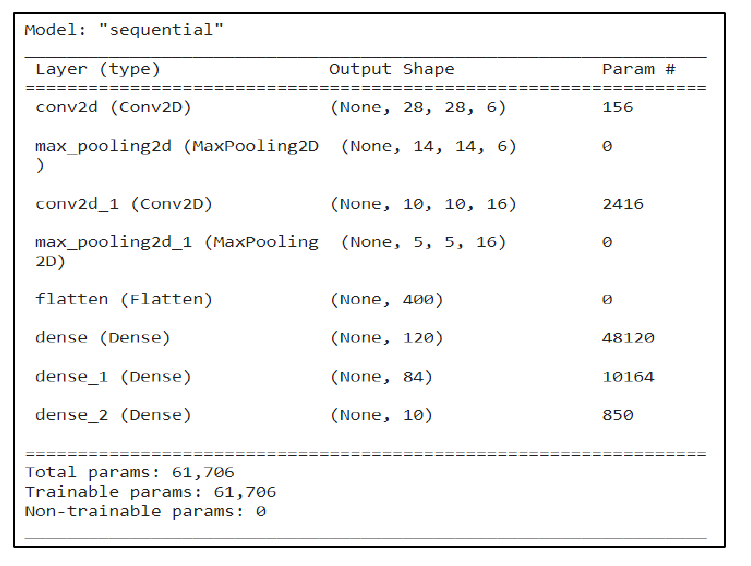
Figure 3. LeNet5 model summary